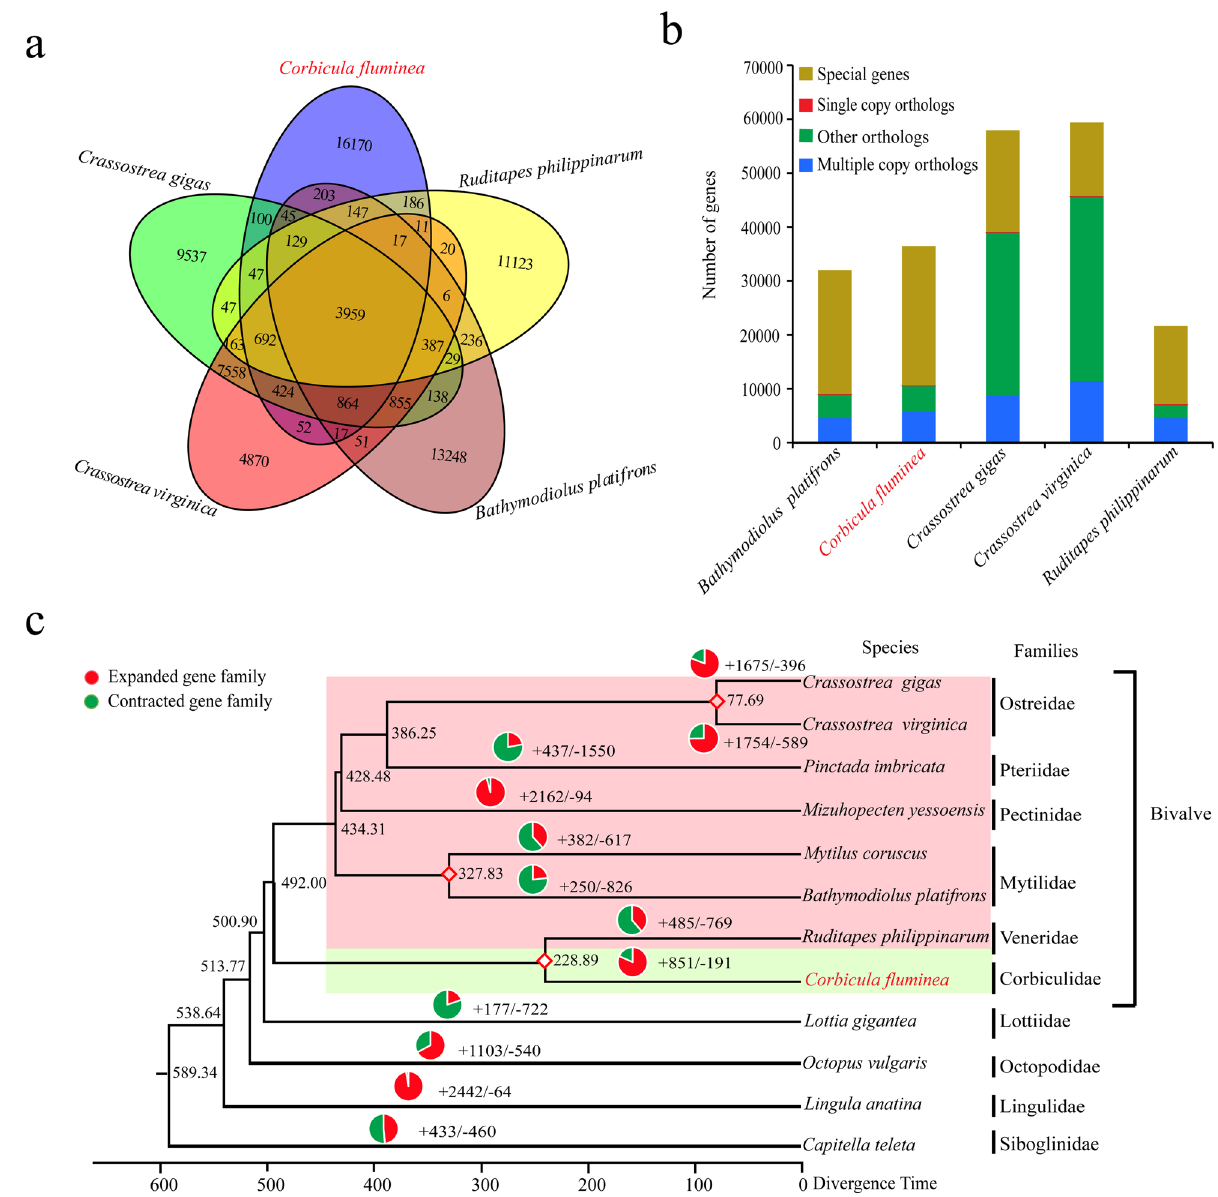
Figure 3. The comparative genomic analysis of Corbicula fluminea and other species. ( a ) Venn diagram of gene families between C. fluminea and Crassostrea gigas , Ruditapes philippinarum , Bathymodiolus platifrons , and Crassostrea virginica . ( b ) Distribution of multiple-copy orthologs, other orthologs, single-copy orthologs, and unique genes in C. fluminea and the above four species. ( c ) Phylogenetic tree, divergence time, and profiles of gene families that underwent expansion and contraction in 12 Table S13). The 851 expanded gene families were clustered by 9,967 functional genes (Table S14). The func- tional enrichment analysis on GO and KEGG of those expanded genes identified 325 significantly enriched (q-value < 0.01) GO terms (Table S15) and 19 significantly enriched (q-value < 0.01) KEGG pathways (Fig. S2, Table S16). Among the significantly enriched KEGG pathways, we found taurine and hypotaurine metabolisms were significantly enriched.